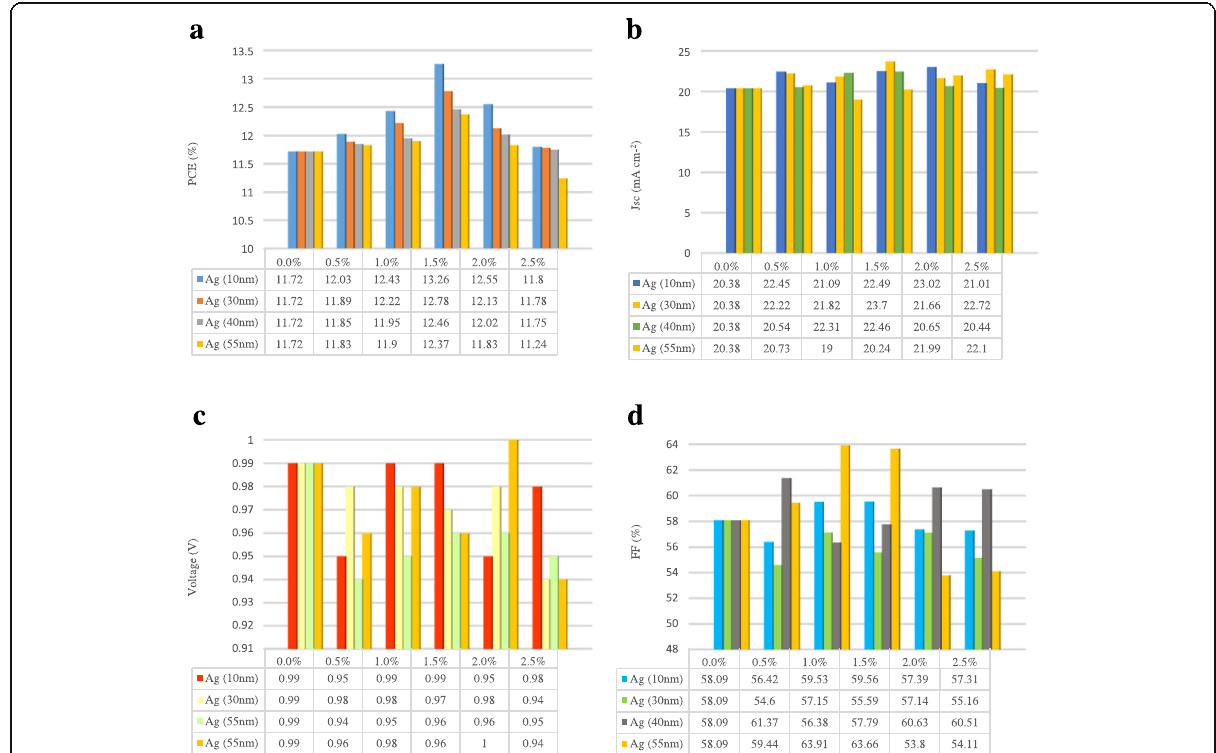
Fig. 7 Two-dimensional histograms and the corresponding tables of a PCE, b J sc , c voltage, and d FF of PSC devices with different sizes and content of Ag